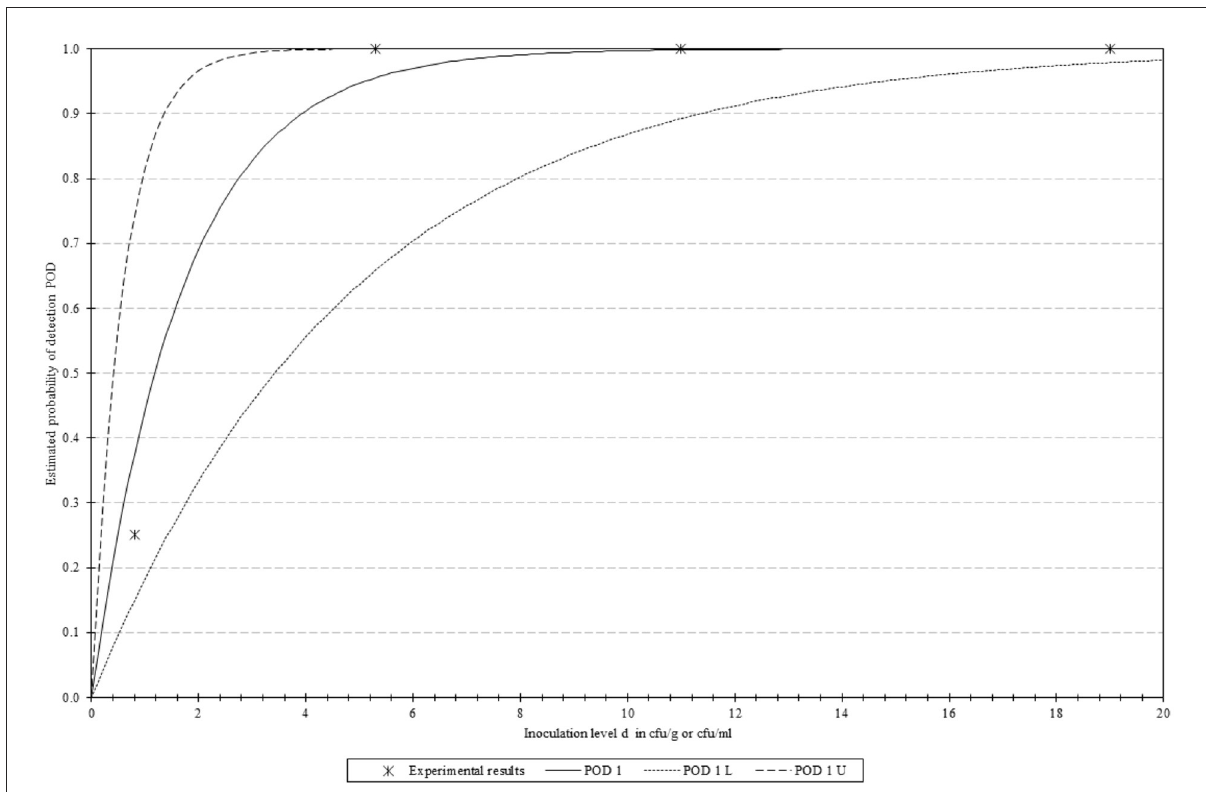
FIGURE3 Graphical representation of the PODLOD results. “POD 1(d)” represents the Probability Of Detection, with “POD 1 L” and “POD 1 U” indicating the lower and upper limits with 95% confidence.